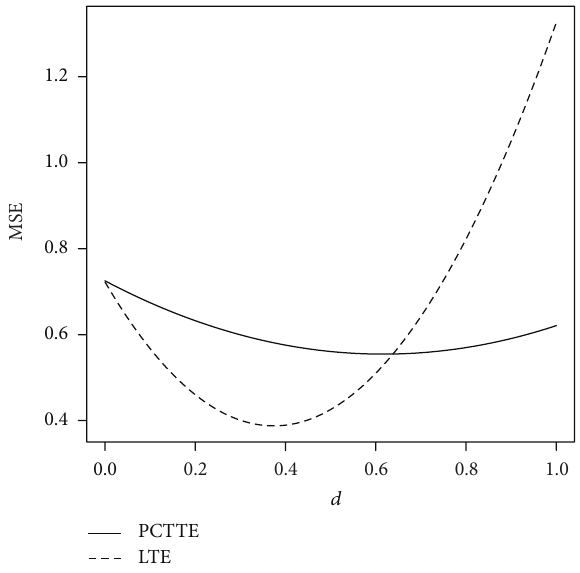
Figure 5: The MSE values of 𝑟 - 𝑘 class estimator and PCTTE when 𝑑 = 0.1 .